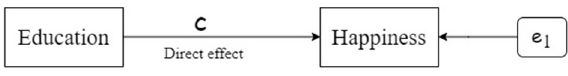
FIGURE 1 | Direct effect of education on happiness.